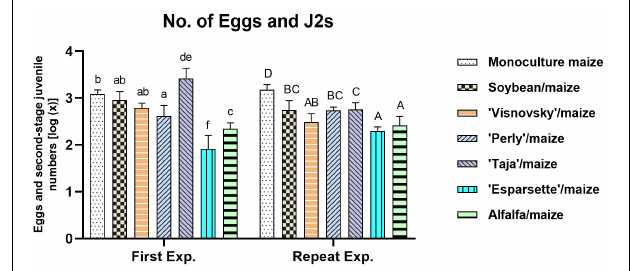
FIGURE 1 | Population densities of Meloidogyne enterolobii in roots of maize, 12 weeks post-inoculation with ± 500 eggs and second-stage juveniles and